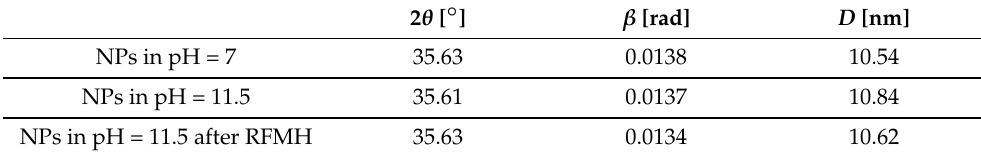
Table 1. The values obtained from XRD analysis for individual